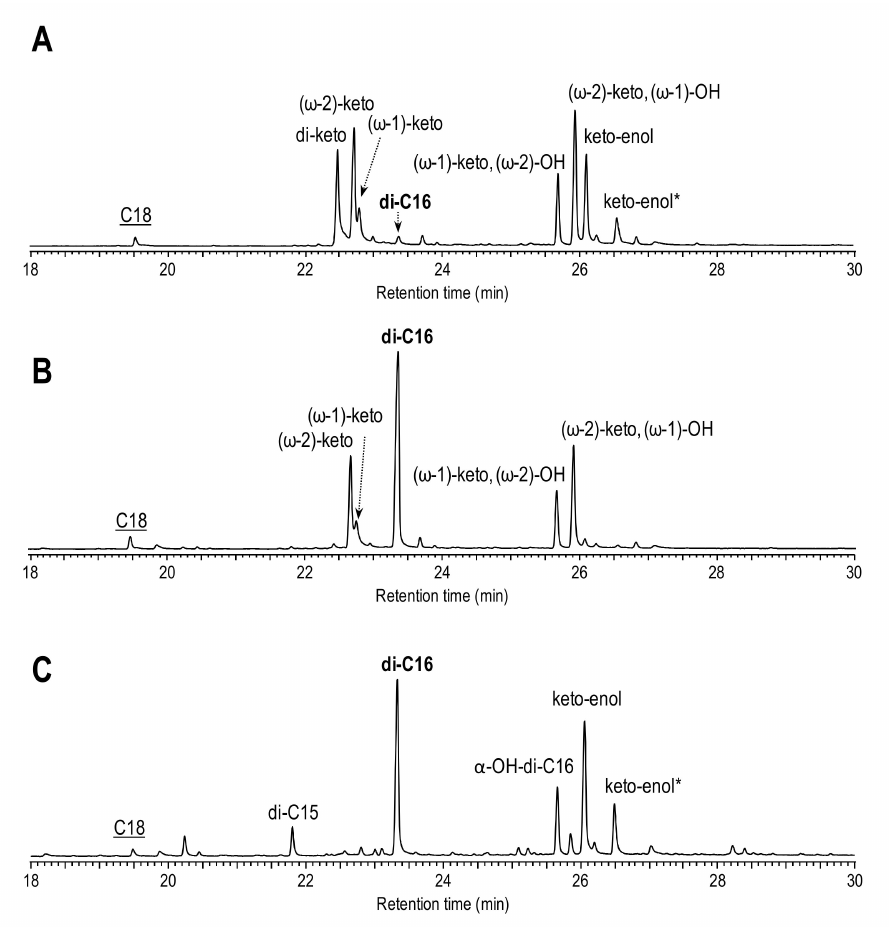
Figure 4. GC-MS profiles of the reaction of 1.2 µ M r Cci UPO with 0.1 mM stearic acid (underlined), after 3 h and 10 mM H 2 O 2 ( A ), extracted and used as substrate of reactions B and C; the products of the reaction A after addition of 15 mM H 2 O 2 during 2 h in the absence of any enzyme ( B ), and the products of A with 1 µ M r Cci UPO after 2 h and 15 mM H 2 O 2 ( C ). The solvent acetone was added in all cases (40% vol/vol). The 2C-shorter dicarboxylic acid (in bold) is shown together with the hydroxy, keto and enol derivatives. Peaks with asterisk were tentatively identified as keto-enol